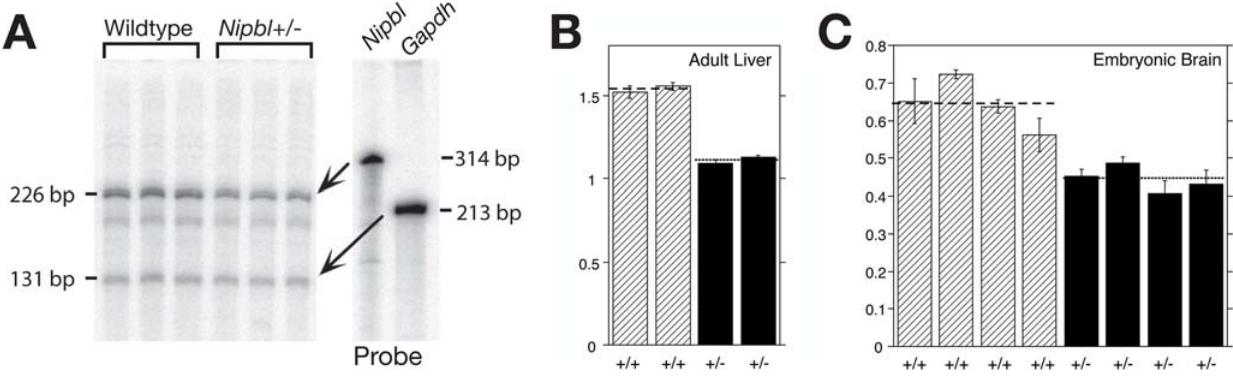
Figure 5. Nipbl transcript levels are reduced 25–30% in Nipbl + / 2 mice. (A) Autoradiograms showing Nipbl and Gapdh probes, and protected fragments of 226 (representing Nipbl exons 11 and parts of exons 10 and 12) and 131 bases ( Gapdh ), respectively. RNA was prepared from livers of two female littermates (N 0 generation; age=119 days). The minor protected band at , 185 bp (corresponding to the size of exon 11) most likely arises from the presence of unspliced or alternatively spliced mRNA. (B,C) Quantification of Nipbl / Gapdh ratios, from autoradiograms such as in (A), for adult female liver [(B); age=73 days], and E17.5 brain (C). Mice in each panel are littermates. Hatched bars=wildtype, filled bars= Nipbl + / 2 . Error bars=SD for triplicate (B) or quadruplicate (C)